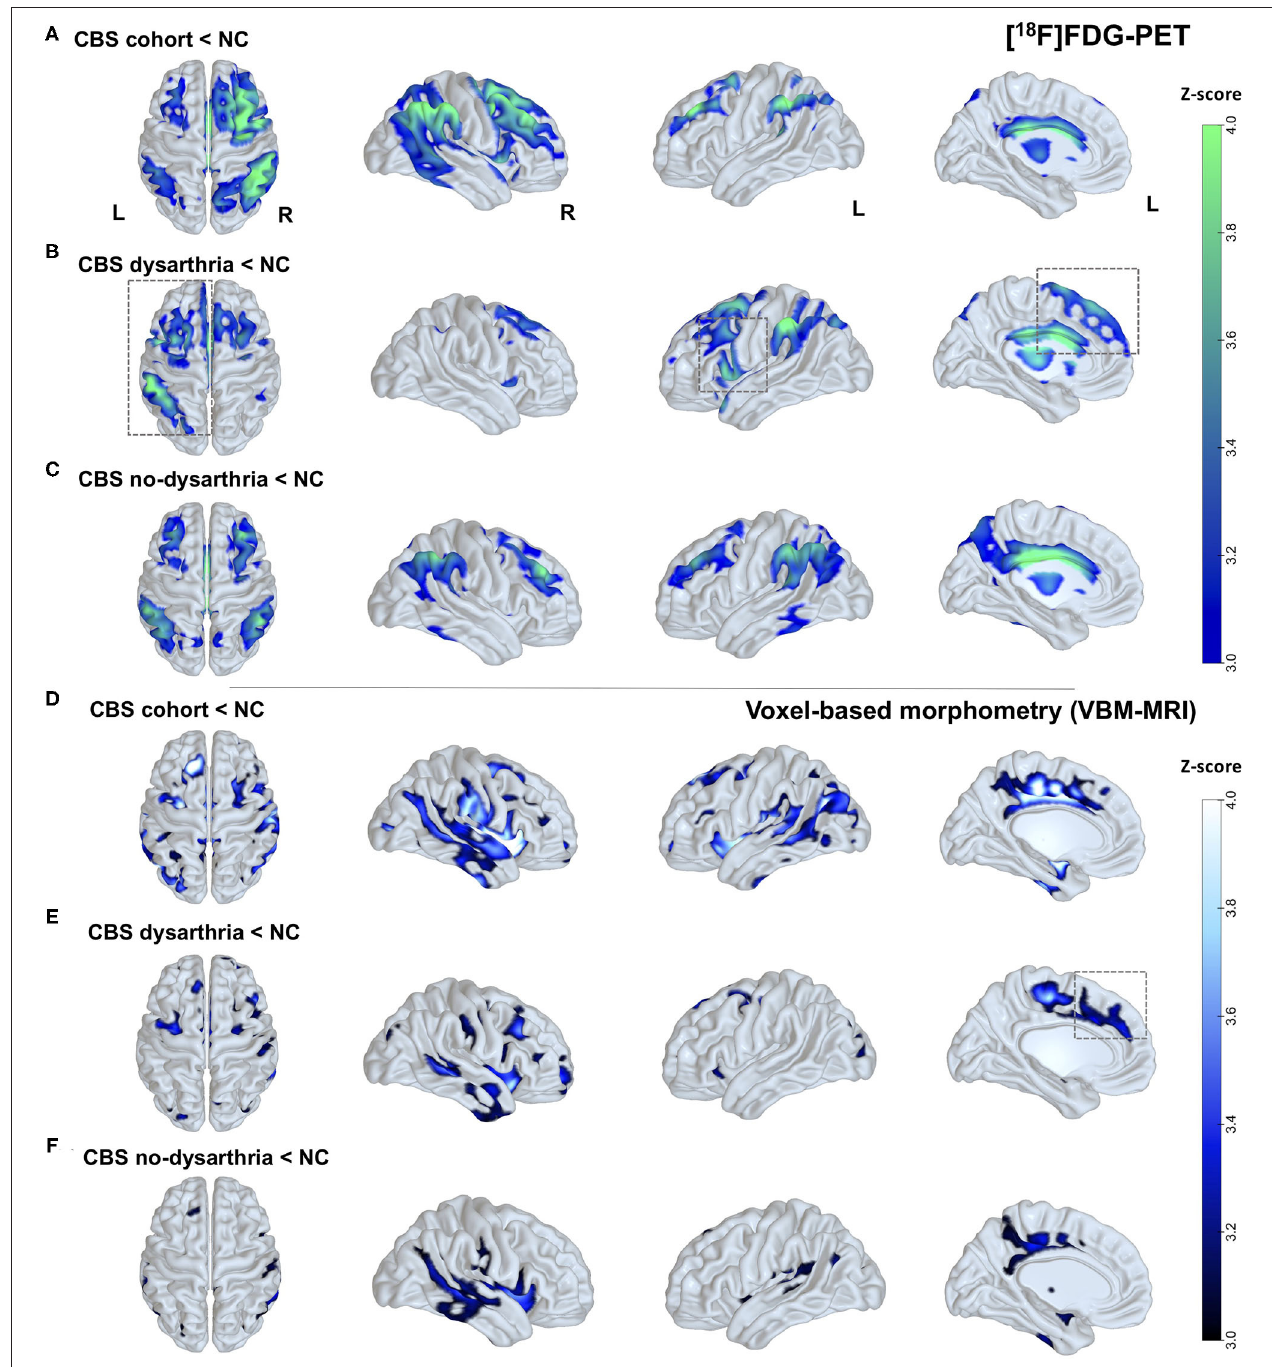
FIGURE 2 | Brain glucose metabolism and brain atrophy patterns in patients with CBS and according to the presence or absence of dysarthria. (A) Clusters with differences in rBGM in individuals with CBS compared to healthy controls (NC). Reduced [ 18 F]FDG uptake in the whole CBS cohort is consistently seen in the frontoparietal and temporal areas, striatum, and thalamus, mainly contralateral to the most affected side. (B) Clusters with differences in rBGM in CBS individuals presenting dysarthria. Reduced [ 18 F]FDG uptake surviving correction for multiple comparisons at the cluster level is predominant at left frontal regions, with a major cluster at the left inferior frontal gyrus (opercular area) and left premotor cortex. (C) Hypometabolism in CBS patients without dysarthria showing bilateral rBGM reduction, mainly at the temporoparietal areas, striatum, and thalamus, and without hemisphere predominance. (D) VBM analysis showing brain atrophy patterns in CBS patients compared to NC: widespread brain atrophy pattern with major clusters at the bilateral striatum, SMA, and posterior temporoparietal areas, mostly contralateral to the affected body side. (E) VBM showing brain atrophy patterns in CBS patients with dysarthria compared to NC: predominantly in the frontal areas and striatum. (F) VBM showing brain atrophy patterns in CBS patients without dysarthria compared to NC: posterior temporal and inferior parietal areas. Parametric maps were generated with an unpaired t -test ( p < 0.001, uncorrected) in the SPM8 software and plotted on surface maps with the Surf Ice software—http://www. nitrc.org/projects/surfice/). Bars in the right side indicate z scores, ranging from p = 10 − 3 ( z -score = 3.0) to p = 10 − 4 ( z -score = 4.0).